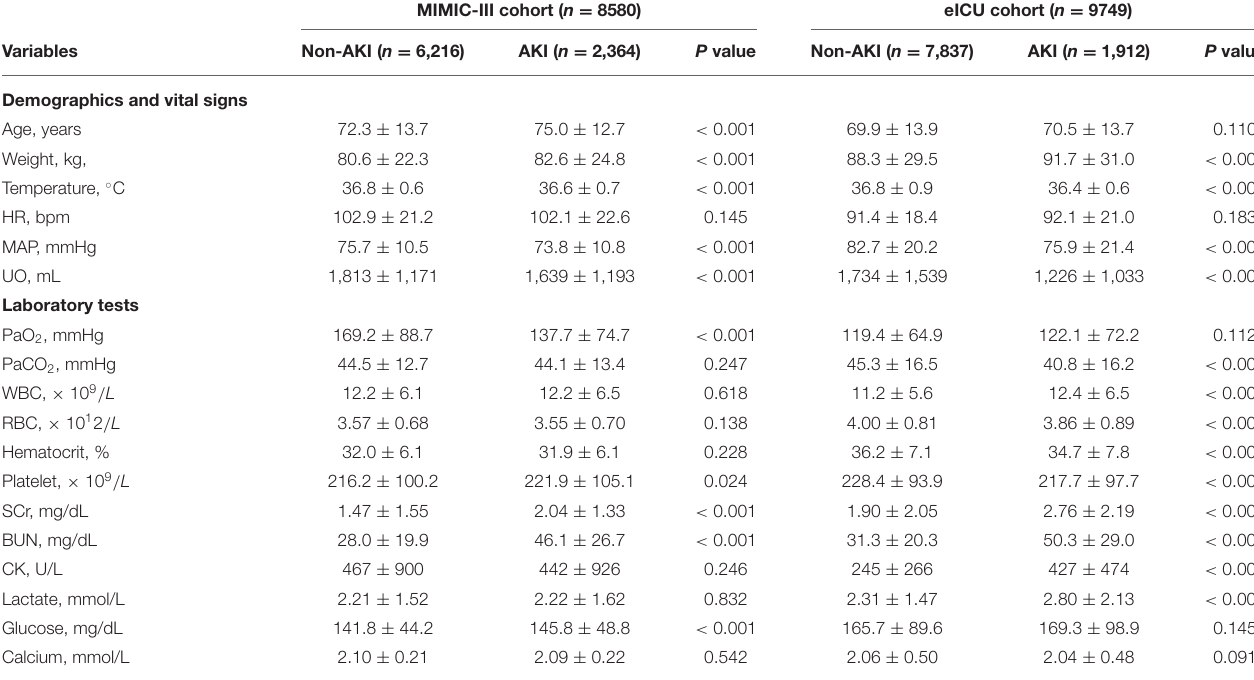
TABLE 1 | Baseline characteristic of the cohorts.